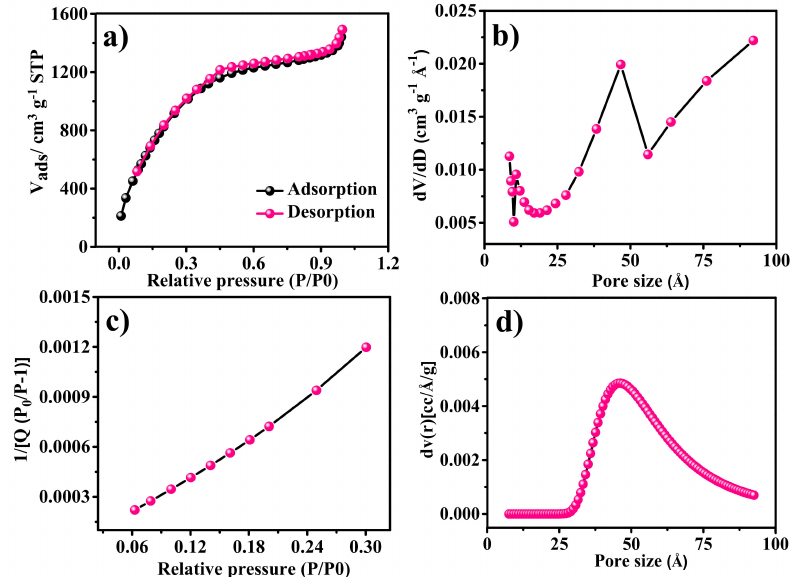
Figure 4. ( a , b ) Surface area, pore-size distribution, and ( c , d ) porosity distribution measurements of